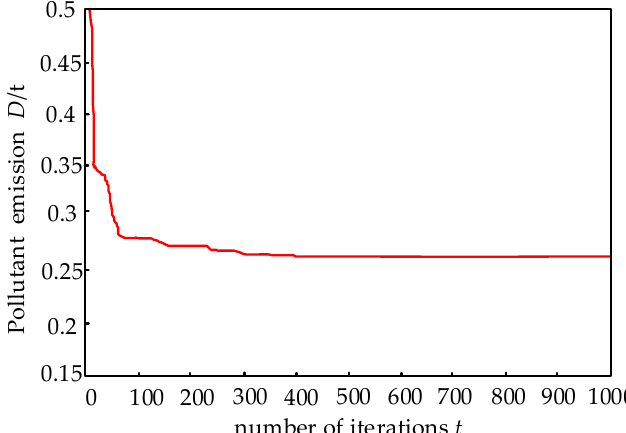
Energies 2018 , 11 , x Figure 12. The change curve of pollutant emissions with the number of iterations (SPSO).